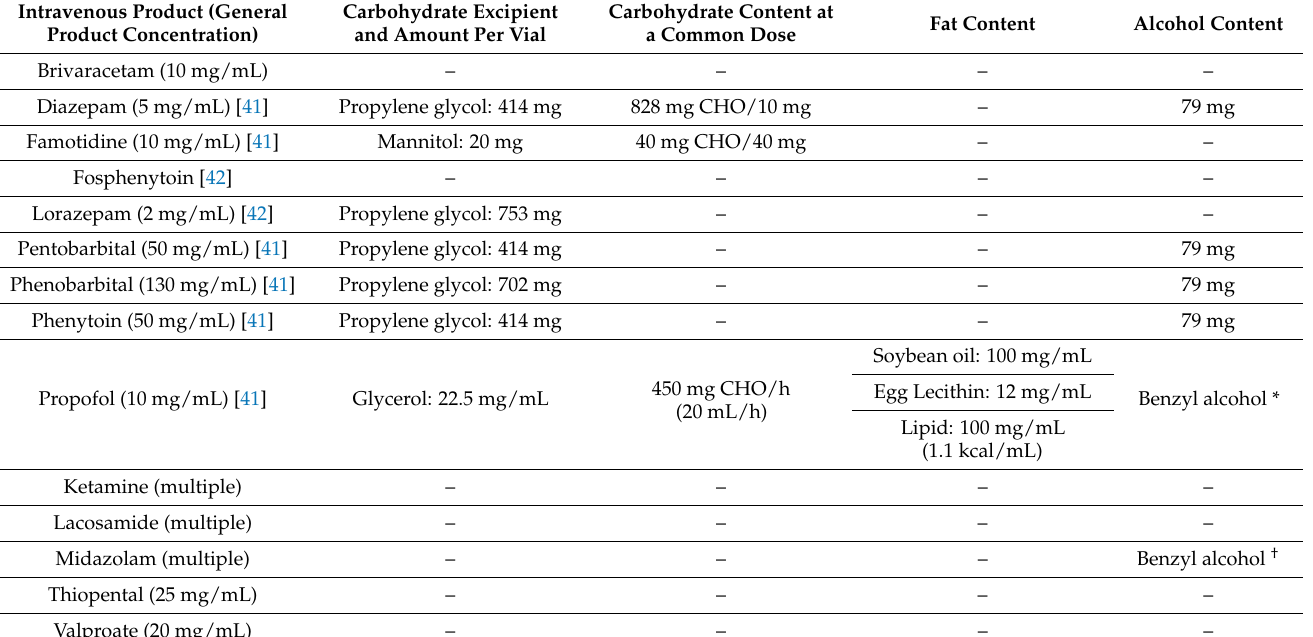
Table 2. Common antiseizure medications, medications utilized in hospitalized patients and associated carbohydrate, fat, and alcohol